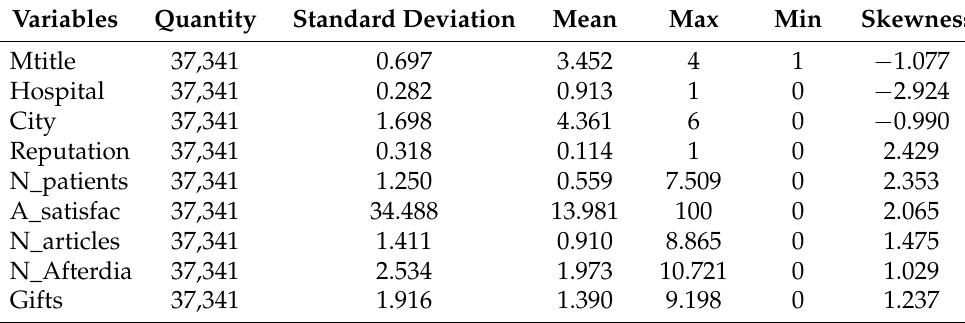
Table 1. Descriptive statistics of variables.